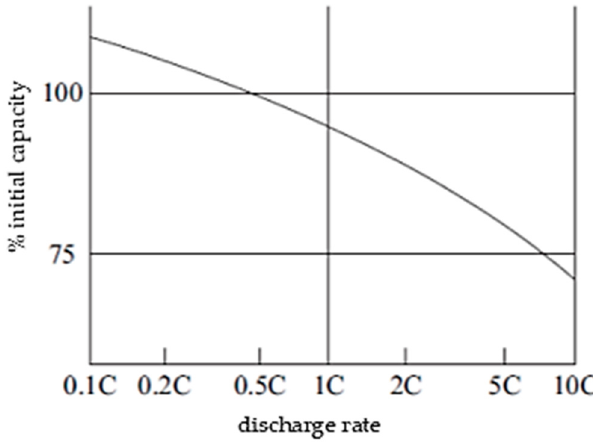
Figure 4. Rate capacity effect [24] with a lead–acid battery.